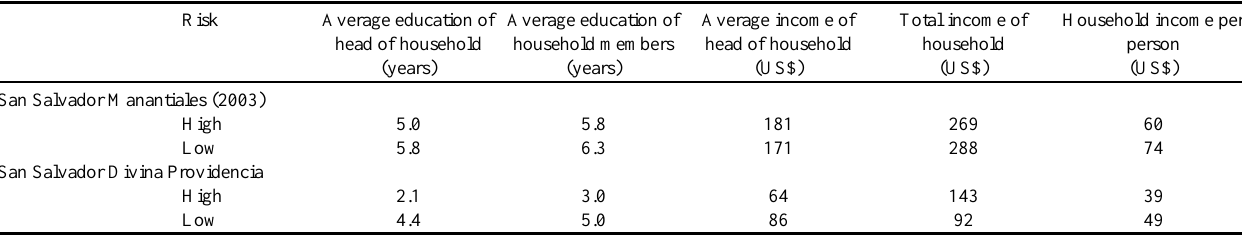
Table 2. Average education and income levels in focus and control groups (i.e., people living in high-risk and lower-risk areas) based on analyses of institutional databases Risk Average education of Average education of Average income of Total income of Household income per head of household household members head of household household person (years) (years) (US$) (US$) (US$) San Salvador Manantiales (2003) High